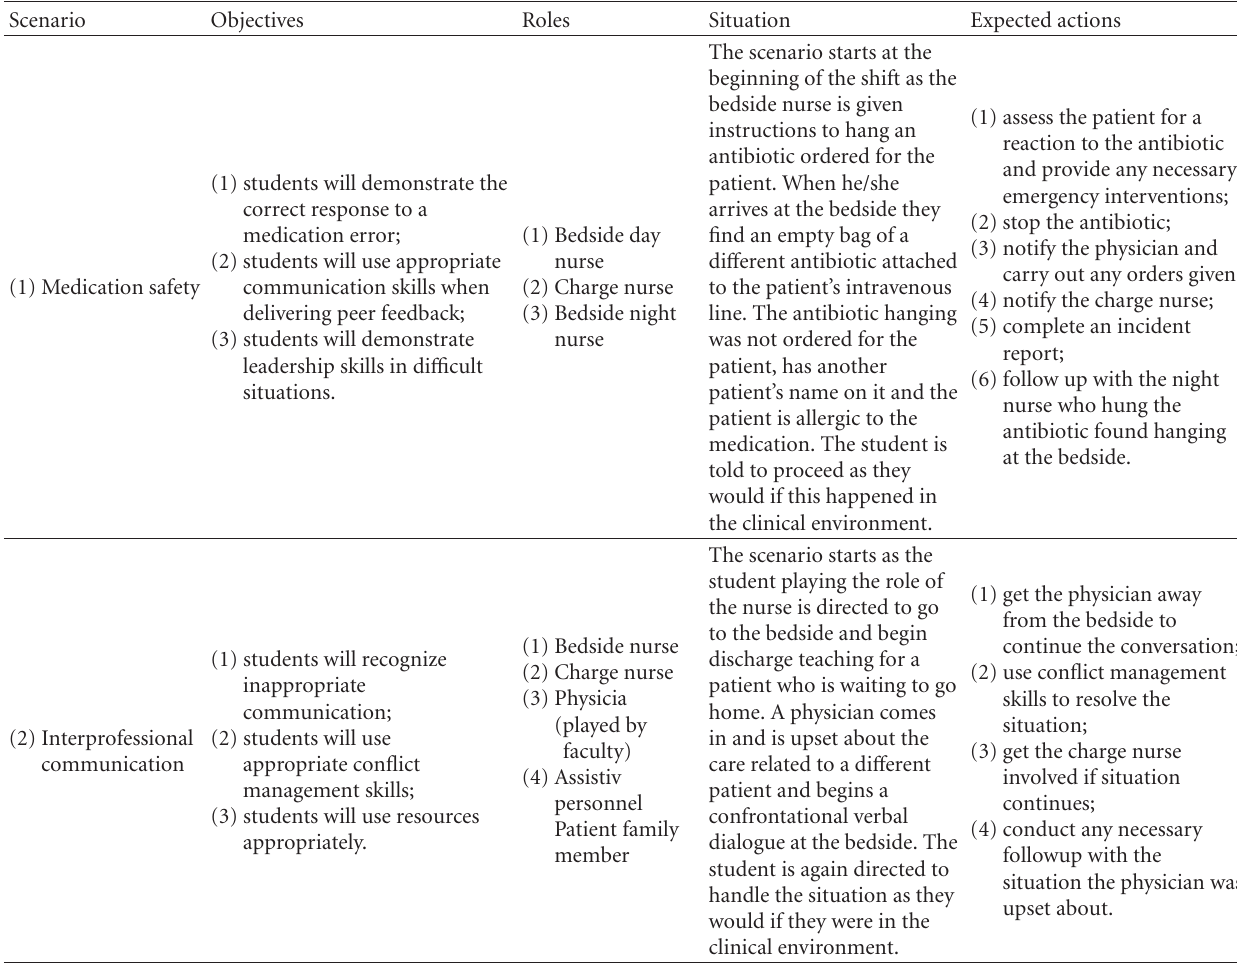
Table 1: Virtual